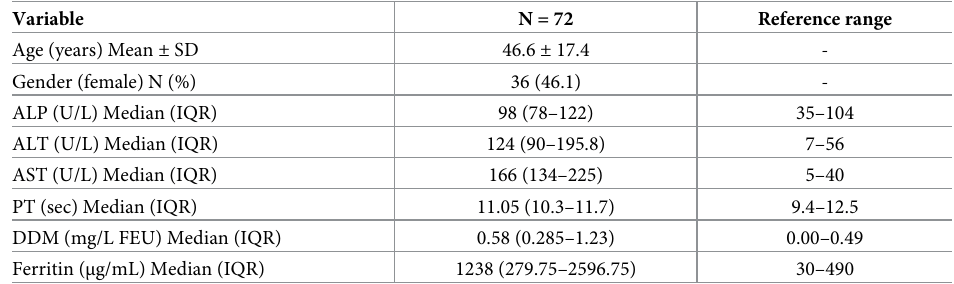
Table 1. Demographic characteristics of the study population (n =